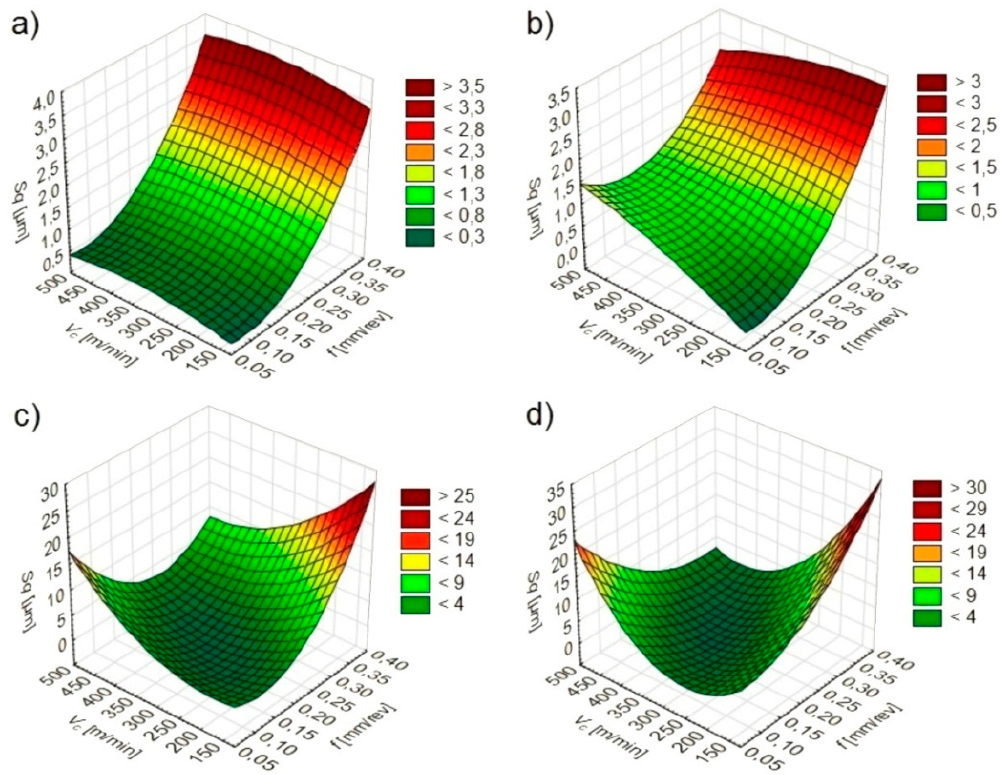
Figure 5. Sq dependence on cutting parameters under: ( a ) dry; ( b ) wet; ( c ) MQL; ( d ) MQL+EP Figure5. Sq dependenceoncuttingparametersunder: ( a )dry; ( b )wet; ( c )MQL;( d )MQL + conditions.